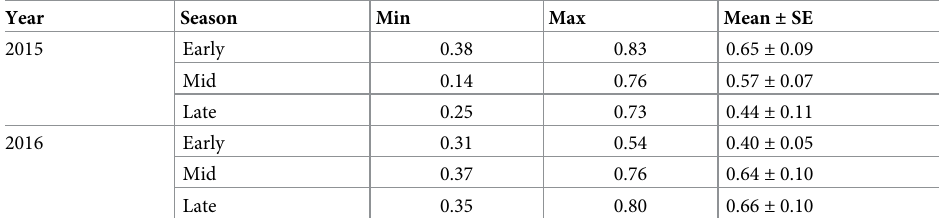
Table 7. Summary of normalized difference of vegetation index (NDVI), n = 81, early, mid, and late season in 2015 and 2016.